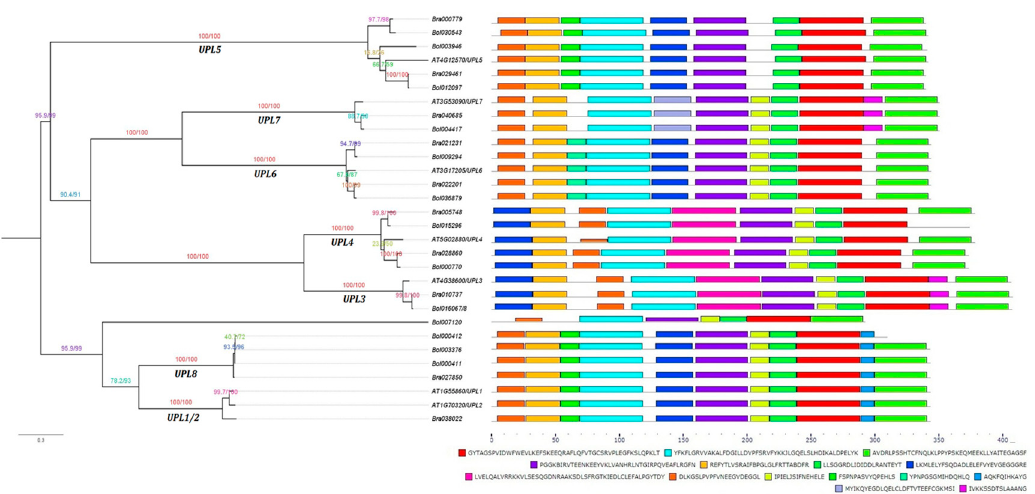
Figure 2. Conserved motif analysis of HECT domains among B. rapa , B. oleracea and A. thaliana HECT proteins. The 15 most conserved motifs were identified by using online the MEME program (http: // meme-suite.org / tools / meme). The maximum likelihood phylogenetic tree is provided on the left side of the figure followed by the di ff erent motifs, represented by di ff erent colors, in the HECT domains of corresponding A. thaliana , B. rapa and B. oleracea HECT proteins on the right side. The black lines showed the non-conserved sequences. The scale bar at the bottom (right side) indicates the lengths of proteins. Sequences of the 15 most conserved motifs are also shown at the